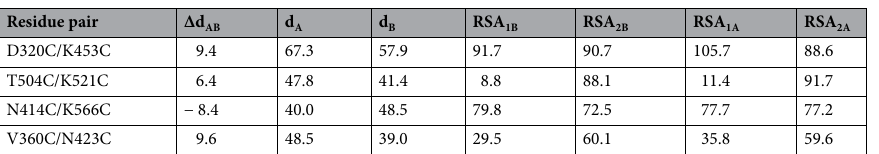
Table 1. Distance and surface accessibility parameters for the original and newly selected mutants. Δd AB is Δd conformationAB in Å, Δd X is Δd conformationX in Å, and RSA nX is the relative surface accessibility of residue n in conformation X and %.